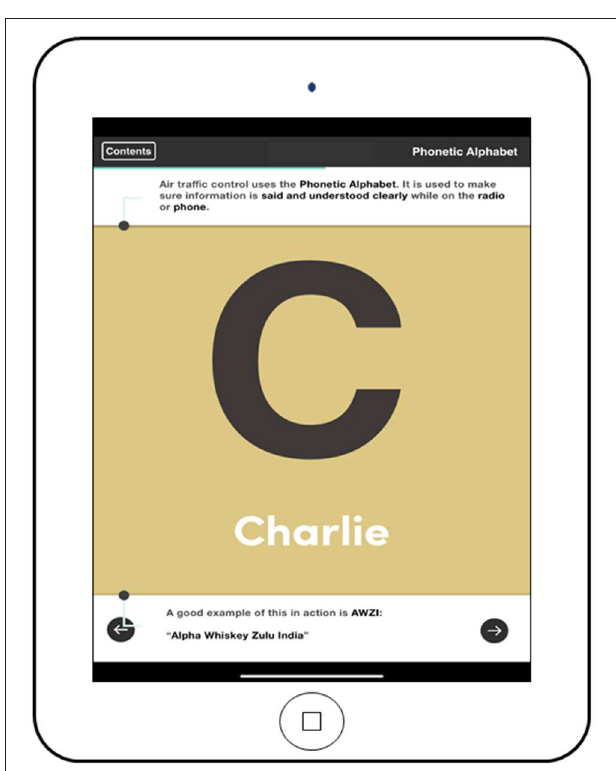
FIGURE 7 | “Phonetic Alphabet” screen of the ACPO starter pack.